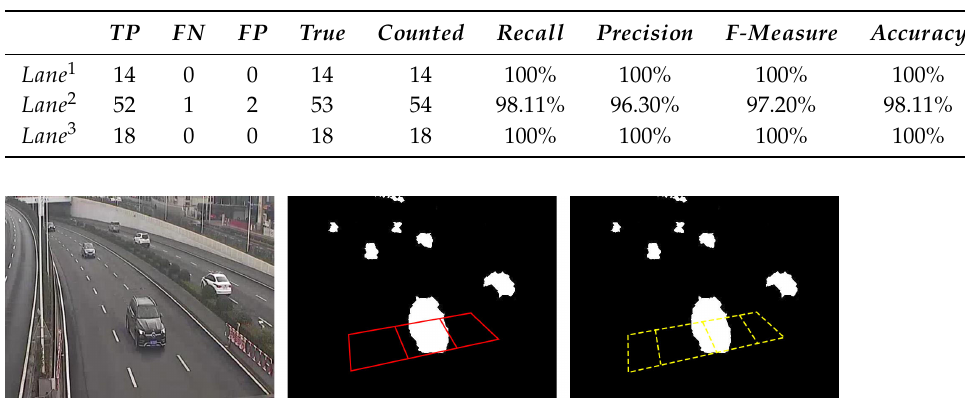
Figure 19. Example of the experimental results in Video V. Table 14. Experimental results of Video VI.